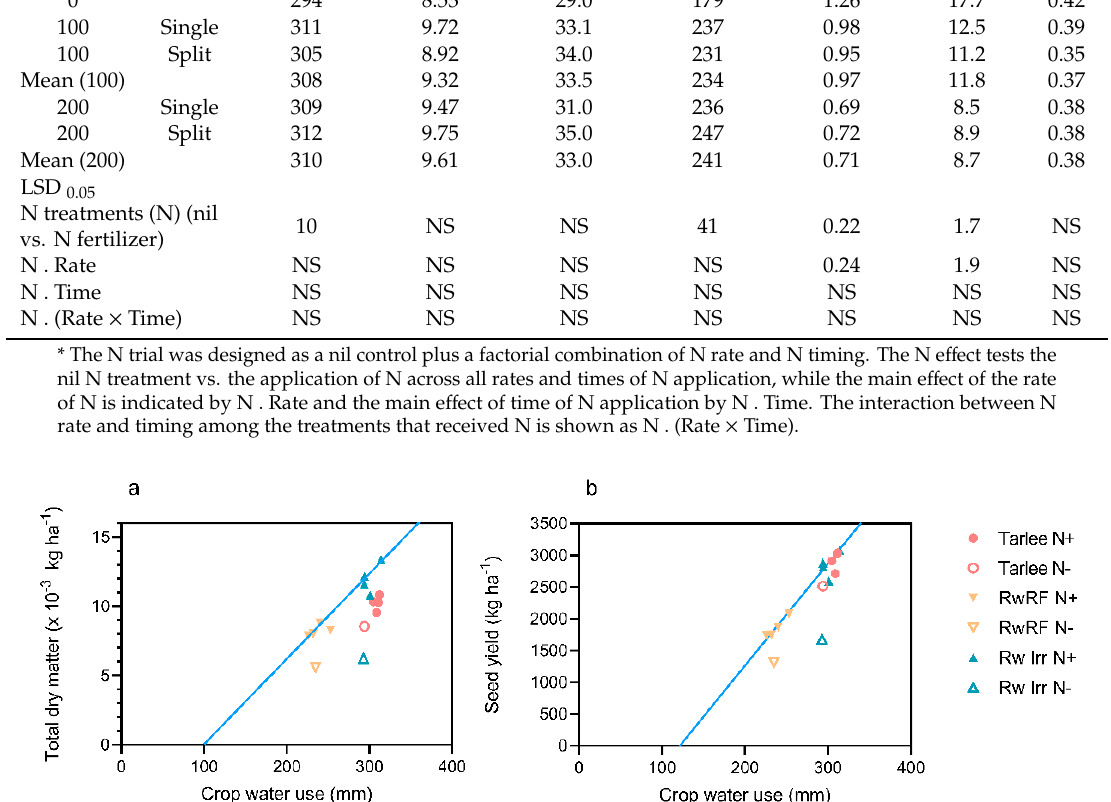
Figure 3. Relationship between crop water use and ( a ) total dry matter and ( b ) grain yield for canola at Tarlee rainfed, Roseworthy irrigated (Rw Irr) and rainfed treatments (RwRF) either with no N fertilizer (N − ) or with N fertilizer (N +